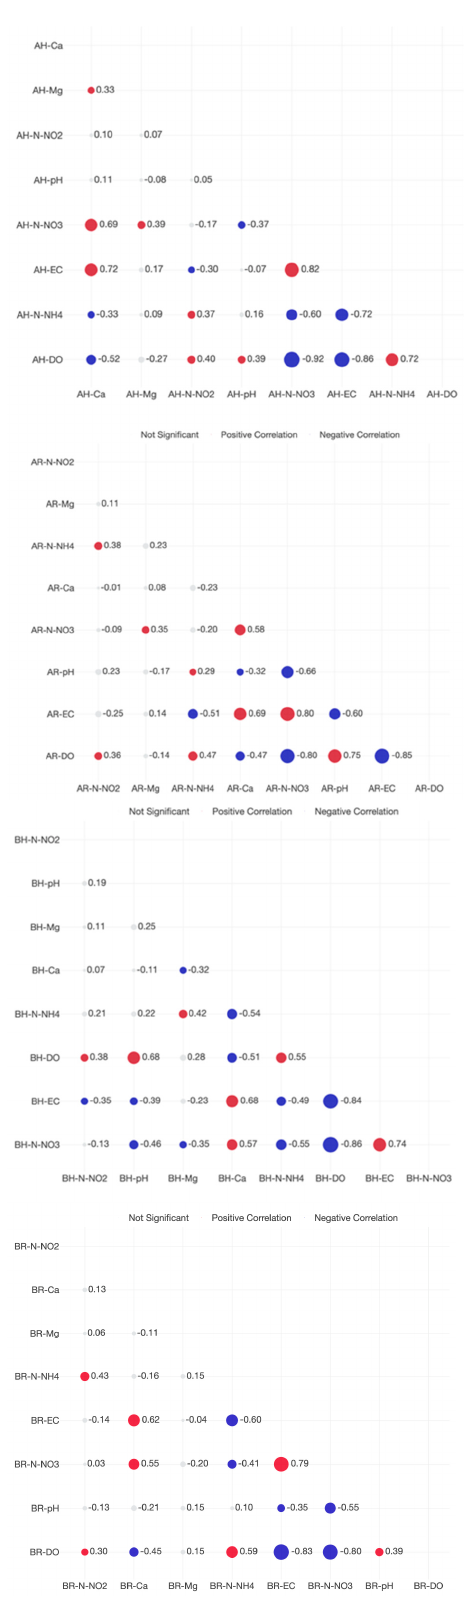
Figure A13. The correlation matrices of water quality parameters for each of the experimental vari- ants.